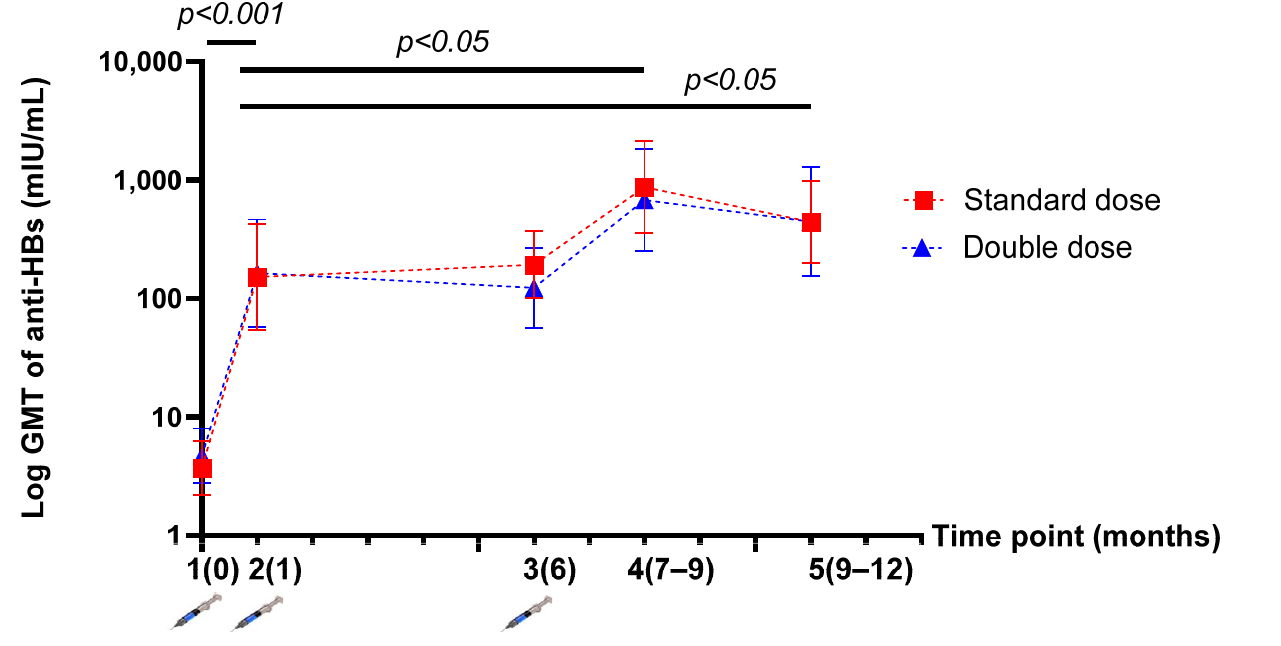
Figure 3. Demonstration of the log geometric mean titre (GMT) of anti-HBs levels before and after vaccination at five time points (per protocol population).